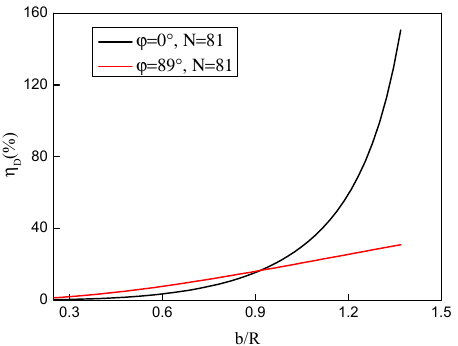
Figure 29. Correlation curves of η D with the ratios of width and radius of the shadow band.